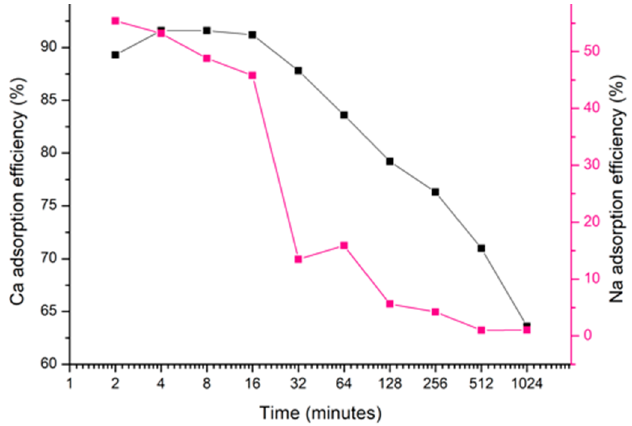
Figure 8. Adsorption efficiency on Ca 2+ and Na + with reaction time. Table 3. The composition of lithium bicarbonate solutions.